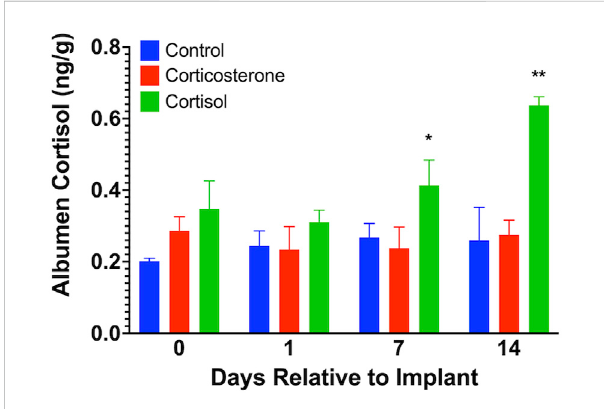
FIGURE 4 Egg albumen concentration of cortisol. Corticosterone was not detected in any samples. Albumen cortisol levels were signi fi cantly increased at 7 and 15 days after cortisol implant, but